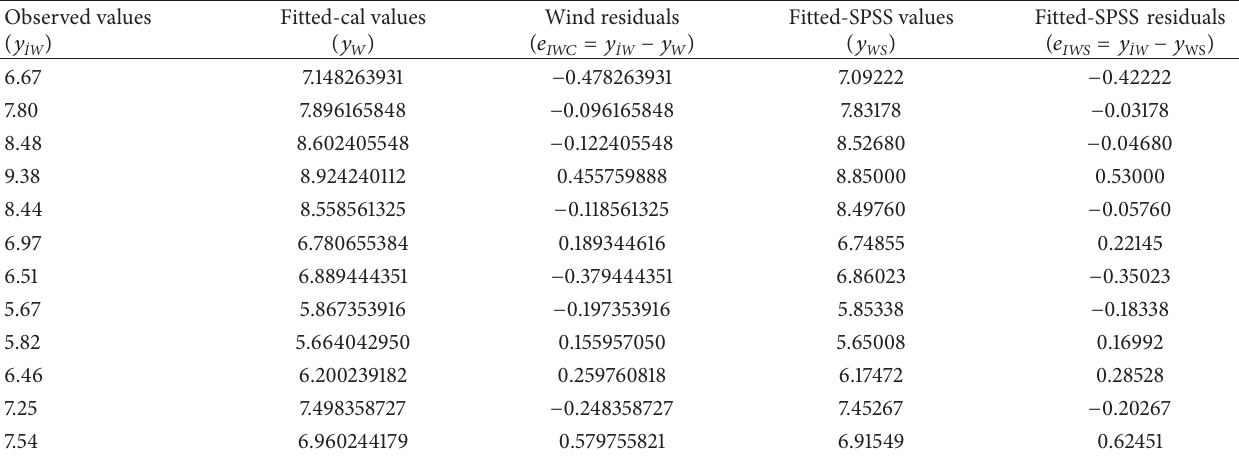
Table 4: Observation values, results, and difference of regression equation when there is a dependent variable wind speed. Observed values